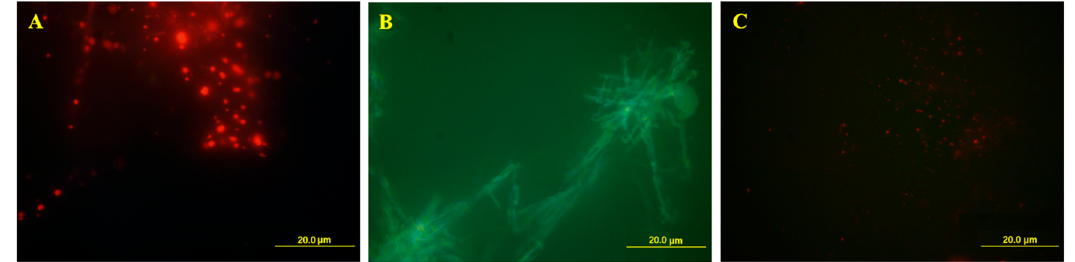
Figure 12. Fluorescence micrographs. ( A ) SDS / CPB system 24 h after preparation (vesicles, R = 1.85); ( B ) 1 month after preparation (crystals); all coming from the same solution. ( C ) SDS / CTAB vesicles system ( R = 1.85), 24 h after preparation.